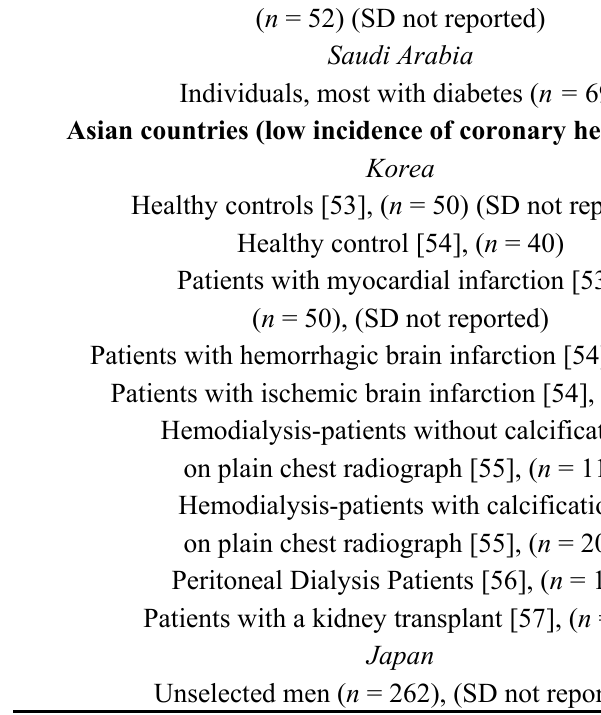
Patients with severe obstructive sleep apnea